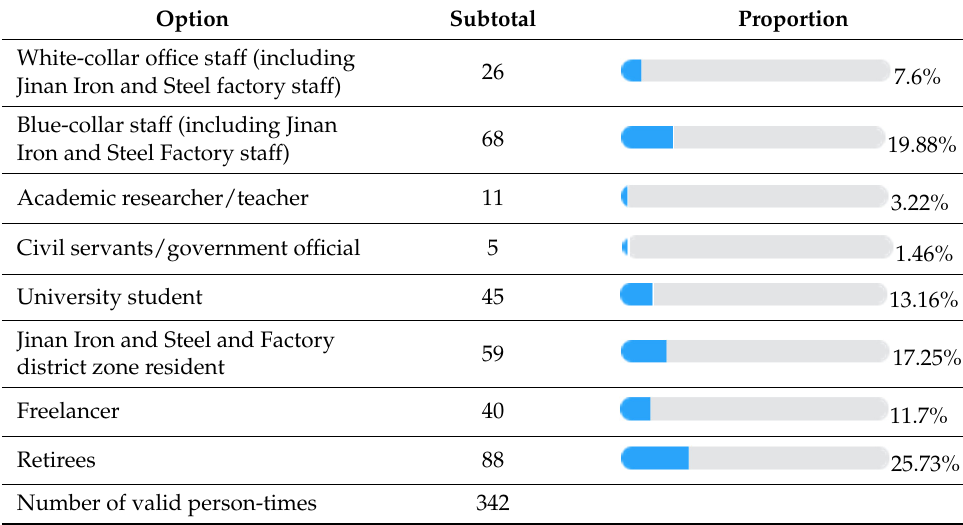
Table 3. Population structure of Table 3. Population structure of respondents. Table 3. Population structure of respondents. Table 3. Population structure of respondents. Table 3. Population structure of respondents. Table 3. Population structure of respondents. Table 3. Population structure of respondents. Table 3. Population structure of respondents. Table 3. Population structure of respondents.